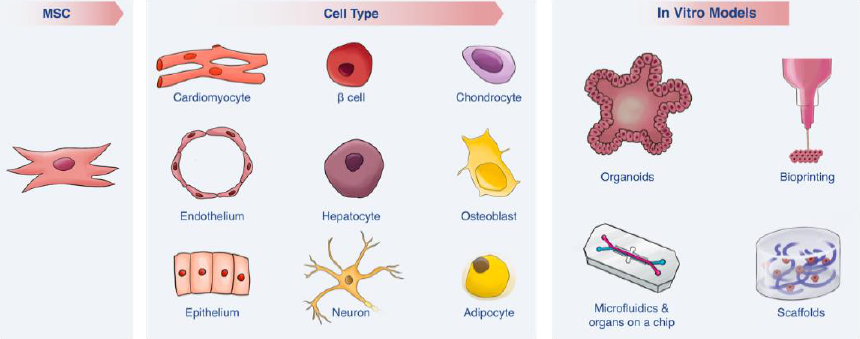
Figure 1. Mesenchymal stem cell (MSC) as a promising cell source for integration in novel in vitro models. MSCs can be differentiated to various of cell types, indicating on its promising potential as a cell source. These potential lineages, as well as MSCs alone, can be integrated with the recent development of novel in vitro tools, such as microfluidics, scaffolds, bioprinting and organoids to enable us providing clinically relevant data, which better mimics the human physiology.